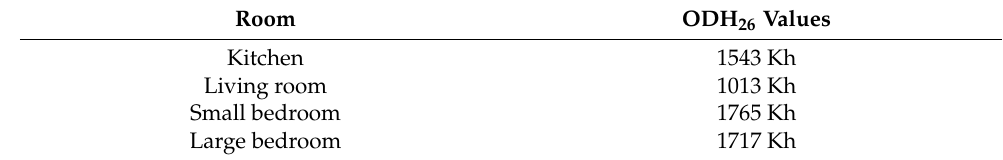
Table 2. ODH 26 values during the measurement period.